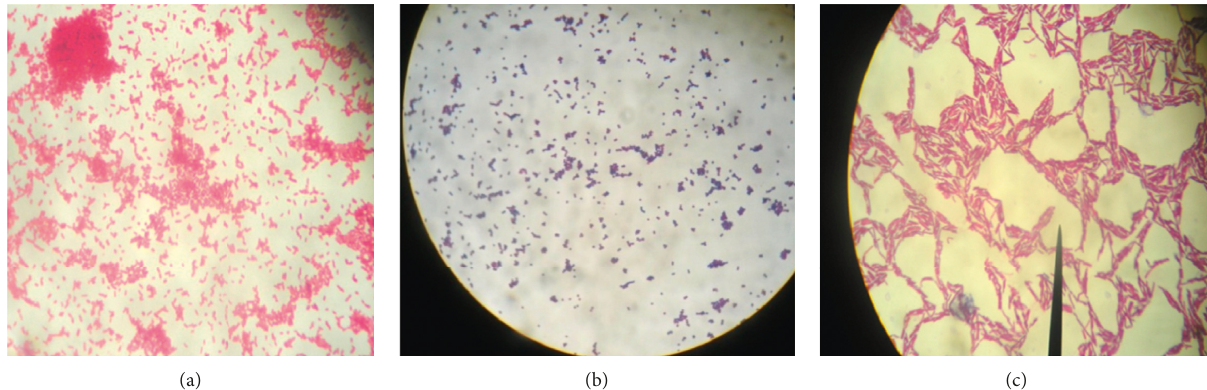
Figure 1: (a) Gram-negative Bacillus (optical microscope obj. × 100). (b) Gram-positive cocci (optical microscope obj. × 100). (c) Gram- positive Bacillus (optical microscope obj. ×